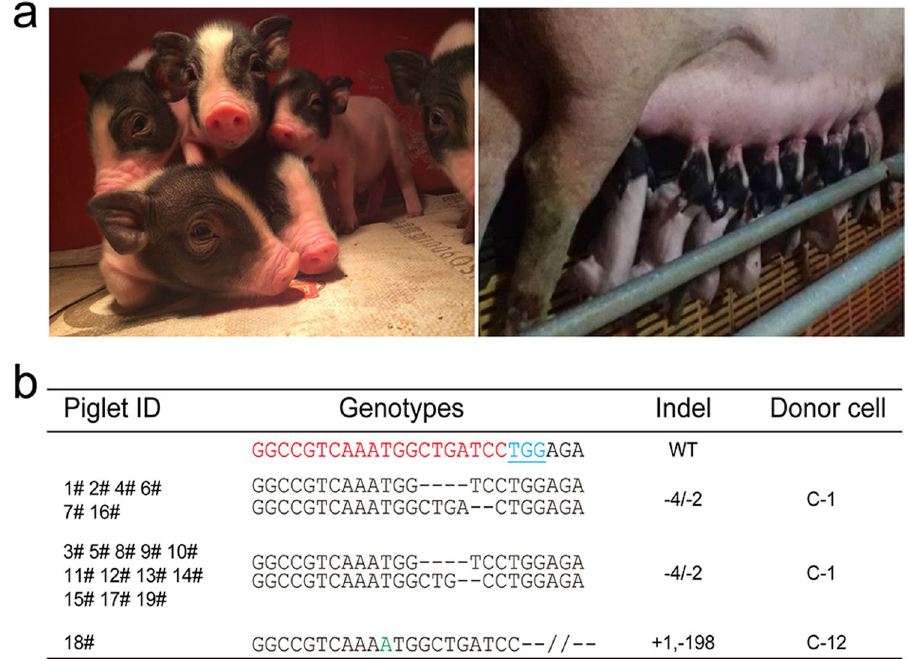
Figure 2. Generation of C3 mutant piglets via SCNT. ( a ) Photograph of newborn cloned piglets carrying C3 gene mutation. ( b ) C3 genotypes of cloned piglets. The wild-type (WT) sequence is shown at the top in which the sgRNA sequences are highlighted in red, PAM sequences in blue, and insertions in green. WT: wild type; deletion ( − ); insertion ( +